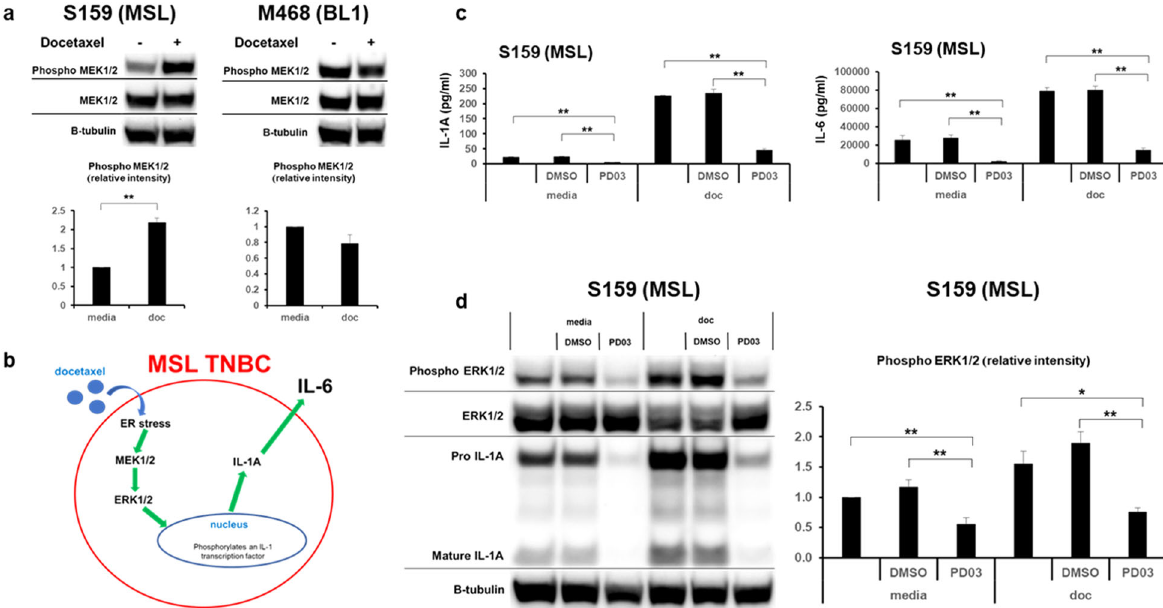
Fig. 3 Docetaxel induced MAPK activity promotes autocrine IL-1A/IL-6 production in MSL TNBCs. a TNBCs were treated in the presence or absence of docetaxel (doc) at 4 ng/ml for 48 h. WB from whole-cell lysates was performed, shown are representative images. Average ± SEM densitometry analysis is from n = 3 biological replicates. b Cartoon representation of MAPK mediated induction of IL-1A/IL-6. c PD 0325901 (PD03) is a MEK inhibitor. MSL TNBC was treated for 48 h at the indicated conditions (doc = 4 ng/ml and PD03 = 1 μ M), supernatants were measured for IL-1A and IL-6. Shown are average ± SEM ELISA results from n = 4 biological replicates. d WB from paired whole-cell lysates to supernatant samples from c , shown is a representative image. Average ± SEM densitometry analysis is from n = 4. Statistical analysis performed with unpaired t -test: * p < 0.05; ** p < 0.01. All indicated experiments are representative of at least two independent